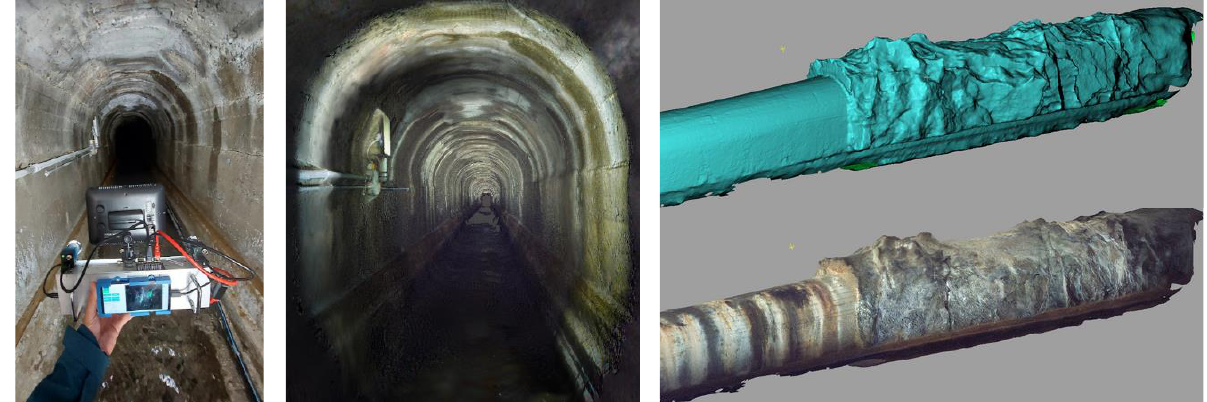
Figure 1. Example of indoor 3D mapping of an underground tunnel using the developed photogrammetric portable mobile mapping system based on vSLAM for real-time guidance. From left to right: the terrestrial prototype in a tunnel, view of the 3D textured model from the inside, shaded and textured mesh from